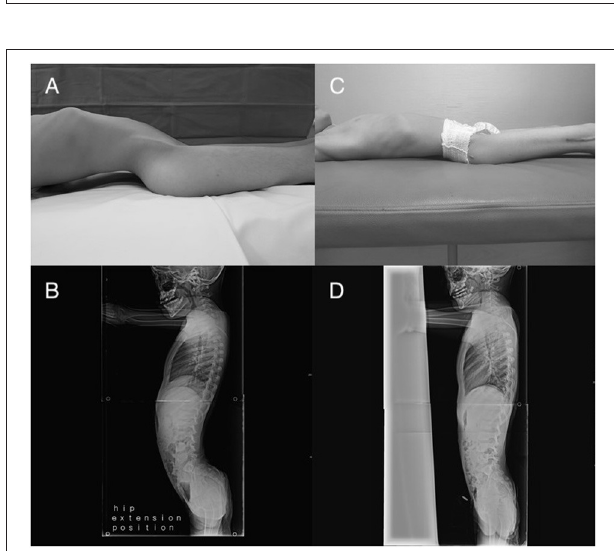
FIGURE 5 | Patient (no. 3) with (A,B) lumbar hyperlordosis observed when lying before surgery. Patient experienced (C) improved comfort and (D) disappearance of hyperlordosis after